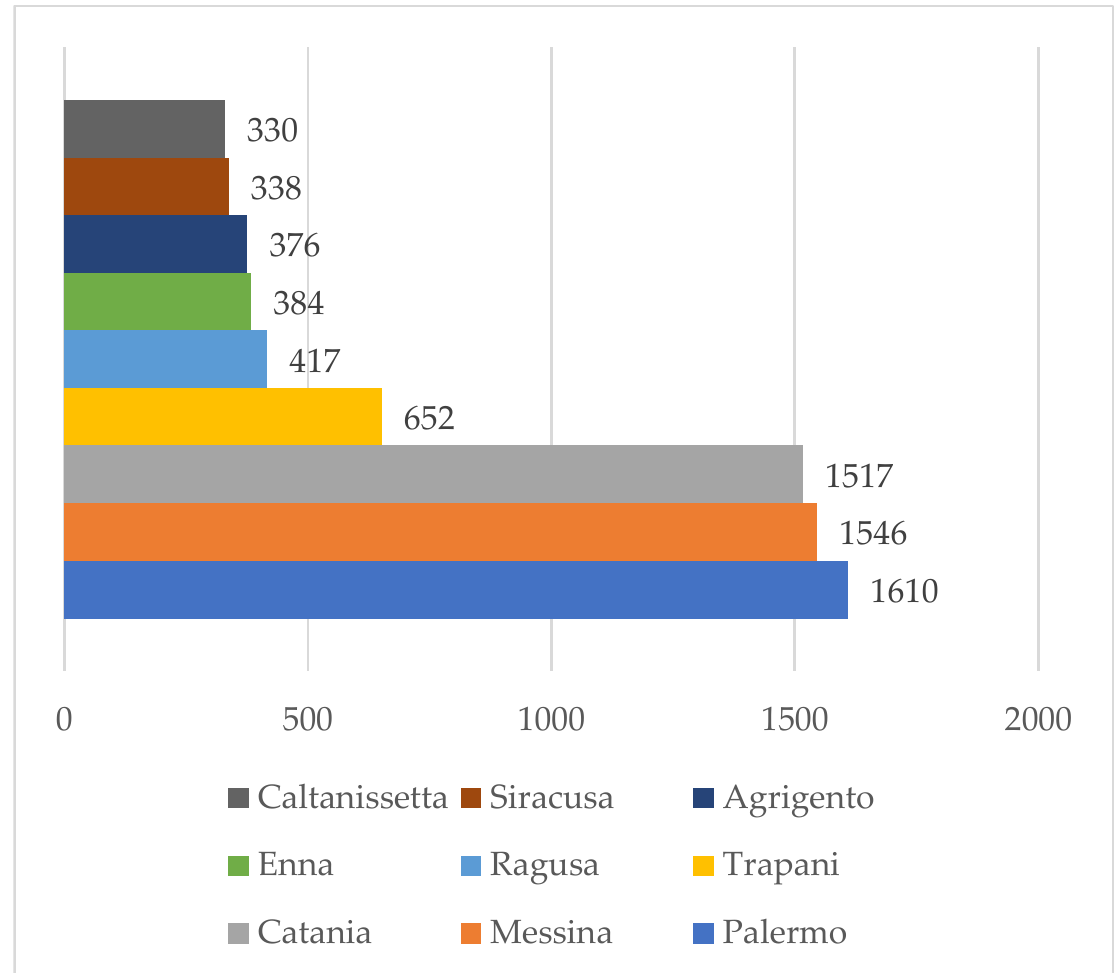
Figure 2. Number of taxa per provinces.